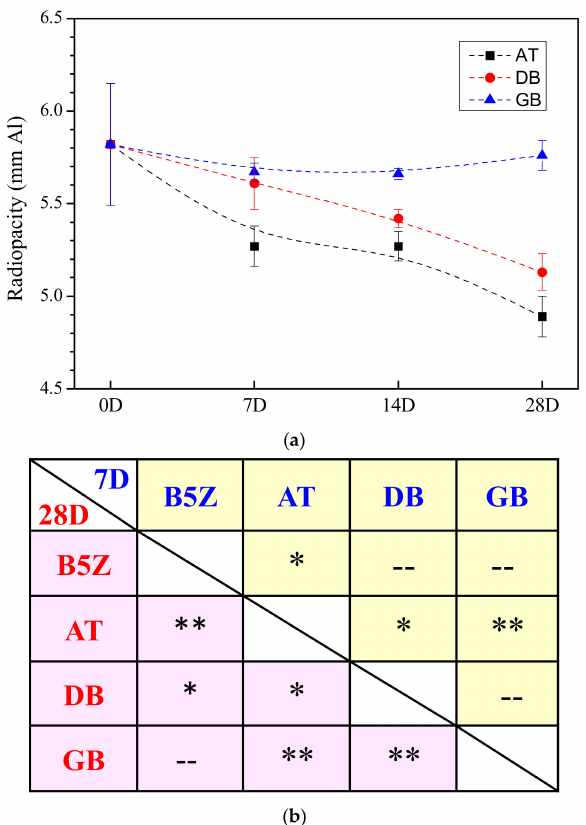
Figure 9. ( a ) Variation of radiopacity and ( b ) comparison between paired samples for MTA-like cements prepared by 30 min as-milled (Bi 2 O 3 ) 95 (ZrO 2 ) 5 powder (coded as B5Z) and stored in ambient (AT), dry box (DB), and glove box (GB) environments after 7 days (7D) and 28 days (28D). “–” designated no di ff erence, whereas * and ** indicated that these two sets of samples were statistically di ff erent at a 95% and 99% confidence interval,